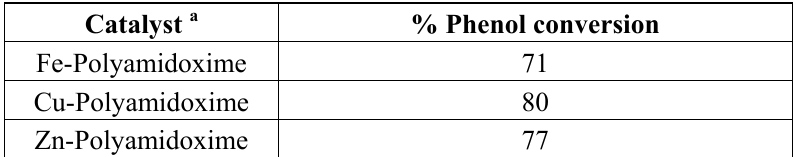
Table 5. Catalyst reuse a